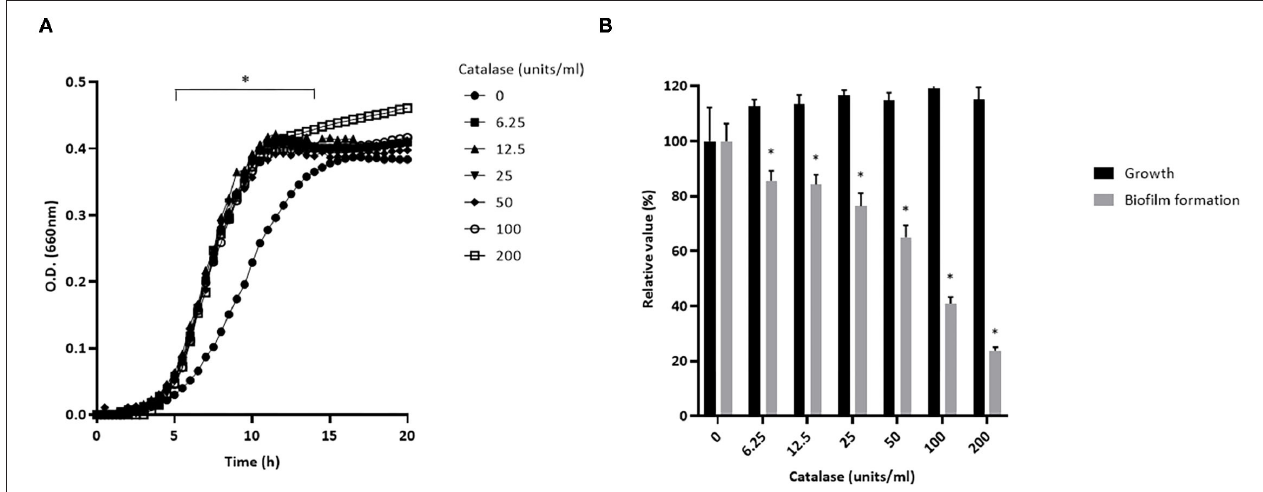
FIGURE 6 | Dose-dependent effect of catalase on the growth (A) and biofilm formation (B) of S. pluranimalium 2N12. Bacterial growth was monitored by recording the optical density at 660nm (OD 660 ). Biofilm biomass was quantified by crystal violet staining. Assays were performed in triplicate in three independent experiments, and the means ± SD were calculated. *Significantly different at p < 0.01 compared to the control (no catalase).